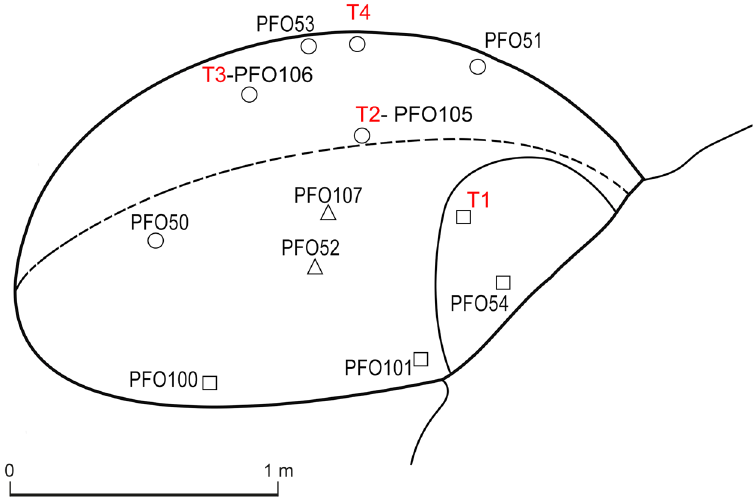
Figure 8: The experimental oven. Position of the analysed samples of hardened sediment ( black ) and thermocouples ( red ) : circle = vault; square = fl oor; triangle = fl oor among